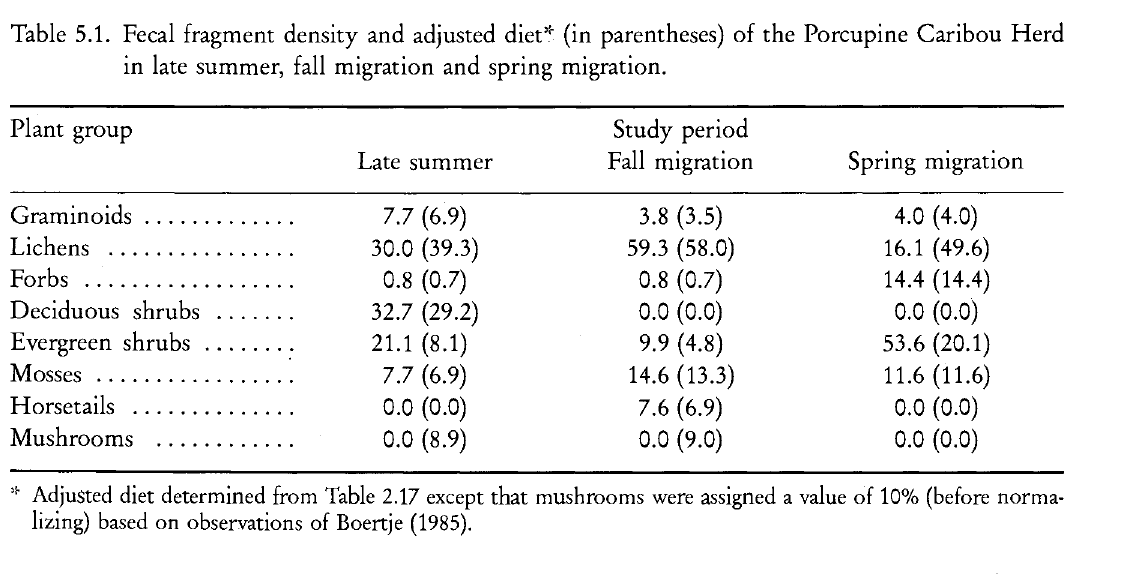
Table 5.1. Fecal fragment density and adjusted diet* (in parentheses) of the Porcupine Caribou Herd in late summer, fall migration and spring migration.